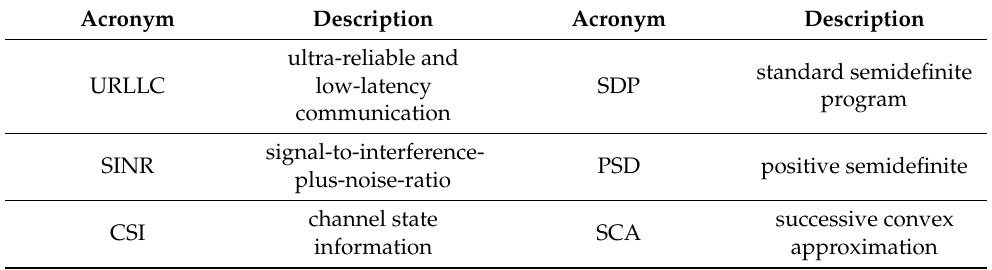
Table A2. List of main